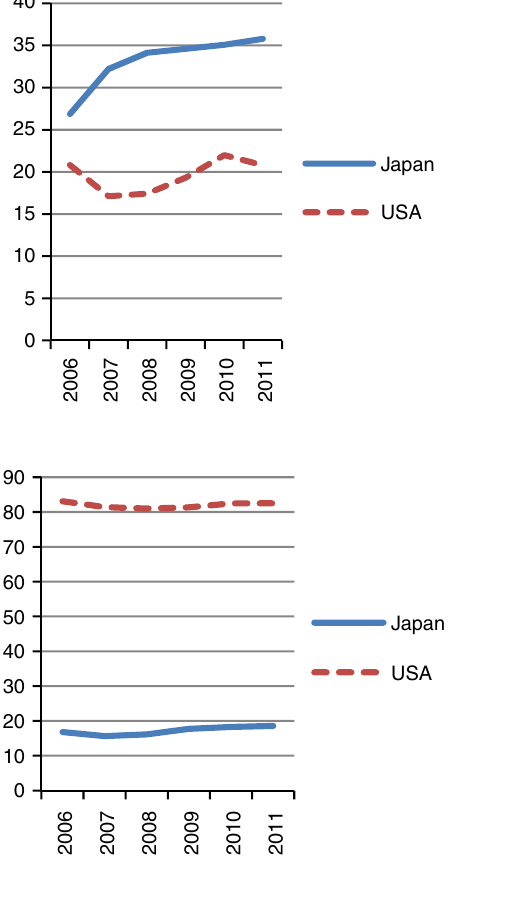
Figure 2. Annual social disclosure score